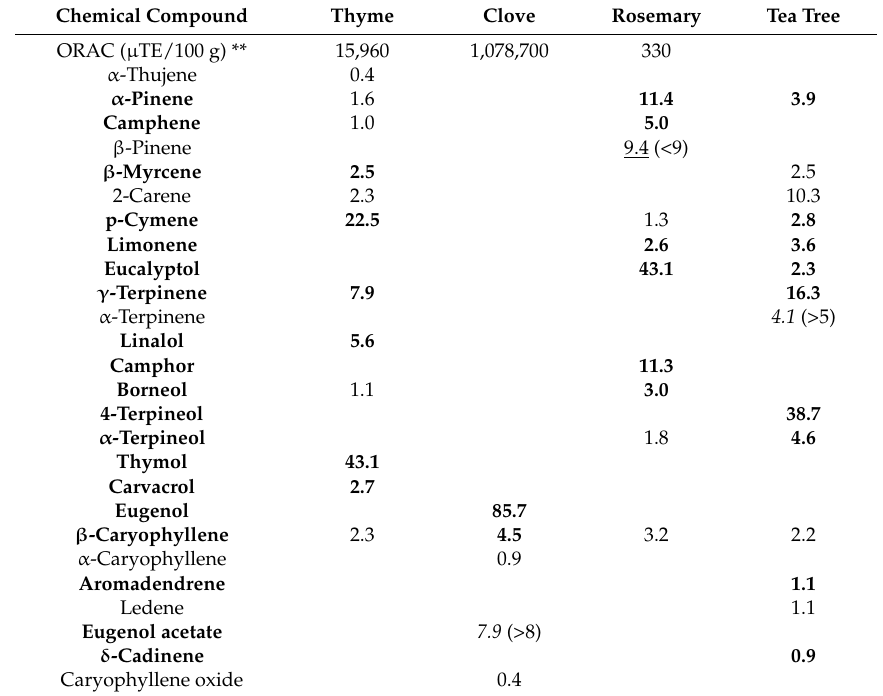
Table 3. The composition of the selected commercial essential oils from the Fares Company, Romania, compared with AFNOR/ISO standards